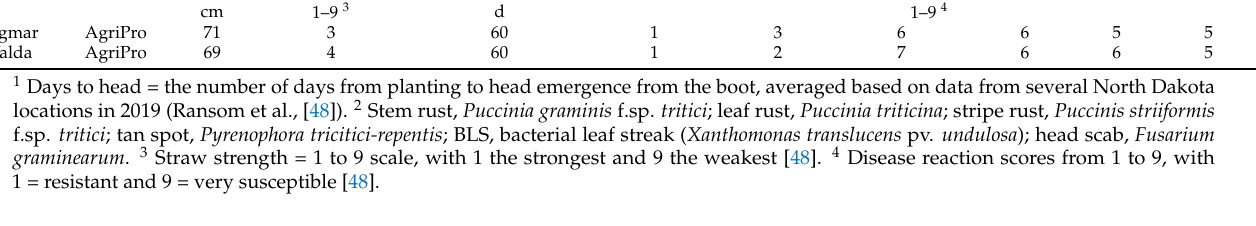
Table 3. Important dates and seeding information for HRSW environments in 2019 and 2020.